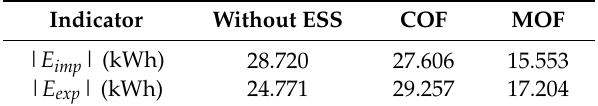
Table 5. Energy import and export for the whole coordinated microgrid.